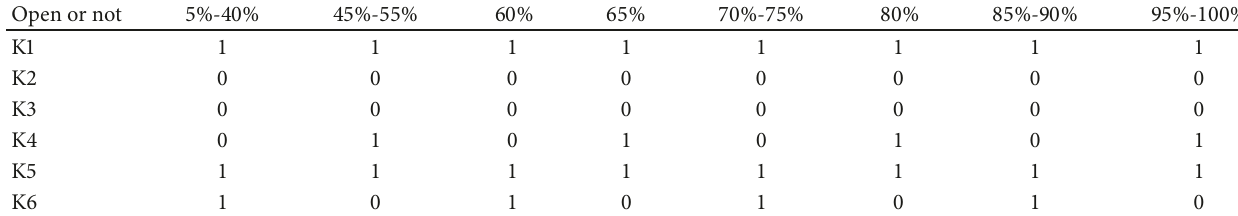
Table 22: Impact of capacity’s ST in landfill.